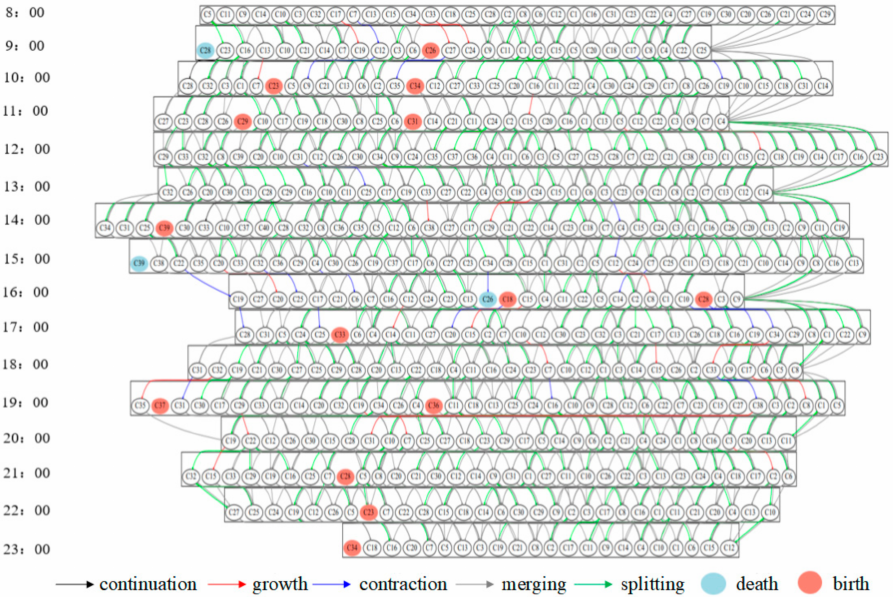
Figure 14. The evolution of the communities identified by EACO in the real-world